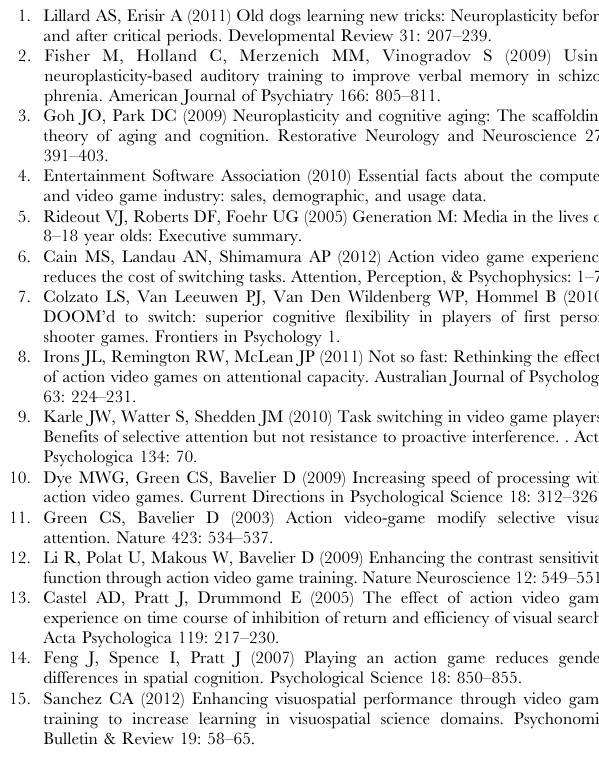
Figure S1 Difficulty level reached by map type for SC-2 and SC-1. Error bars represent standard error. This reflects similar game difficulty and engagement between SC-2 and SC-1. Table S1 Latin square task counterbalancing (MMI= Multime- dia Multitasking Index, BART =Balloon Analog Risk Taking, TS =Task Switching, DS= WAIS-IV Digit Span, ANT= Atten- tion Network Test, Ospan= Operating Span, IF = Information Filtering, VS= Visual Search, MLM= Multi-location Memory). Table S2 Task Switching task, post-test minus pre-test, with standard error in parentheses. Table S3 Stroop test, post-test minus pre-test, with standard error in parentheses.